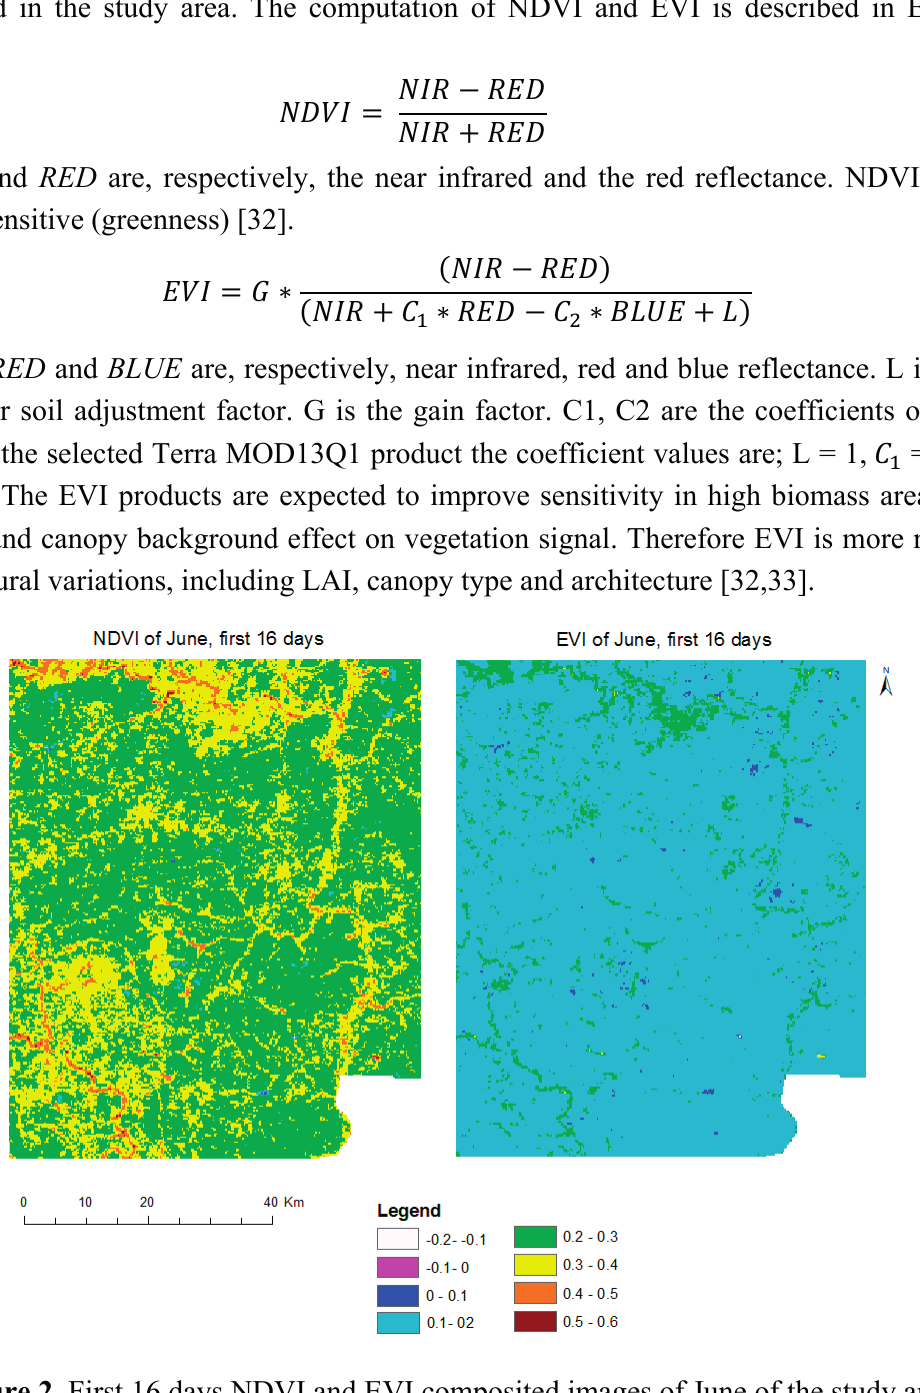
Figure 2. First 16 days NDVI and EVI composited images of June of the study